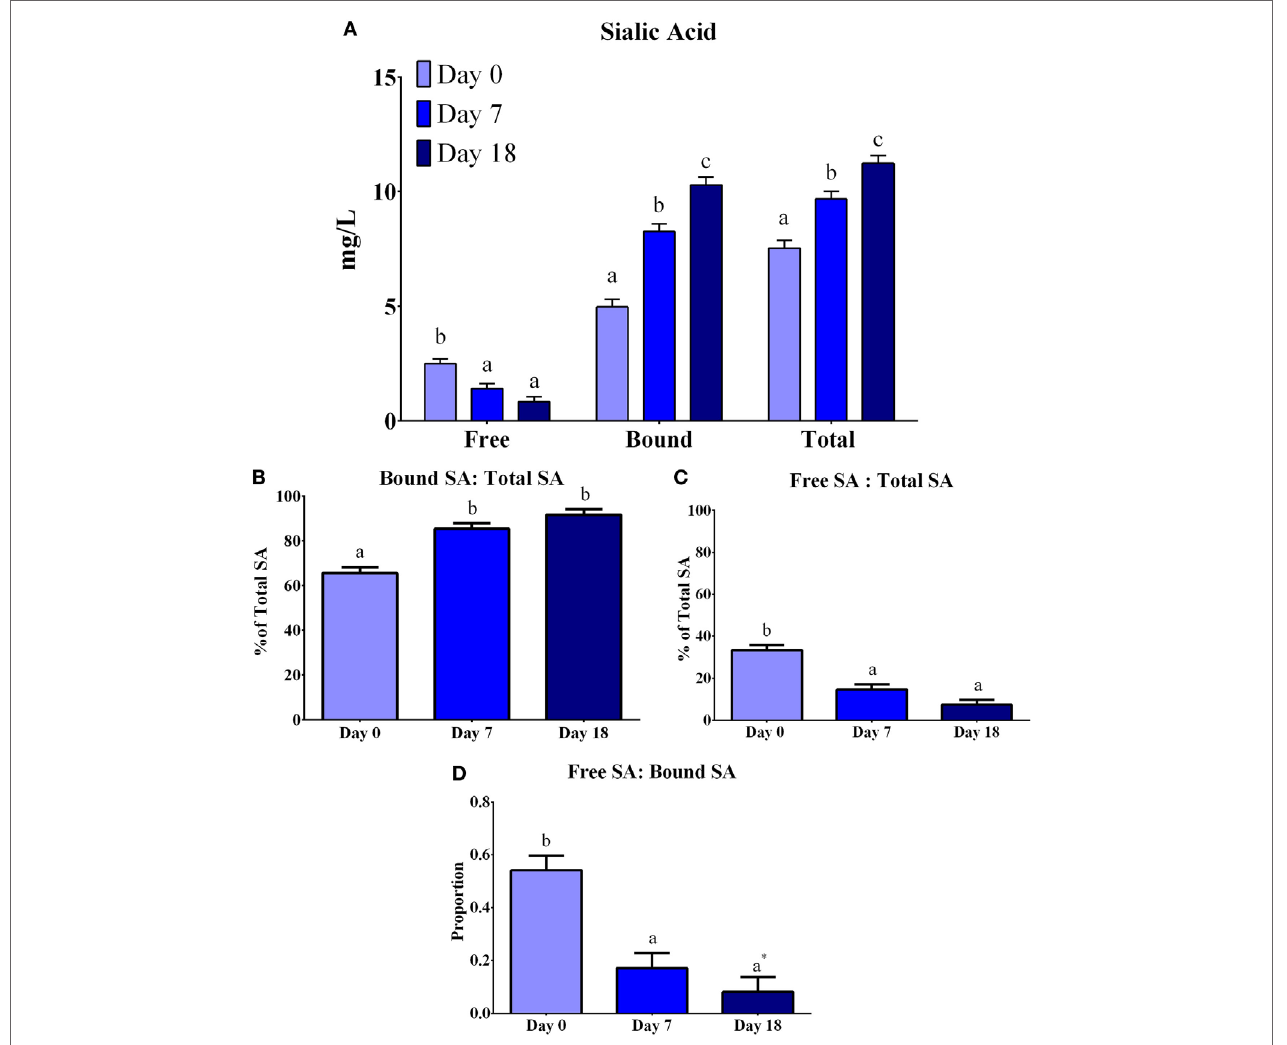
FigUre 3 | Total, free, and bound sialic acid (sa) concentration (expressed as mg neuac/l) in porcine milk . Bound SA was determined from the difference between total and free SA. (a) Concentrations of free SA decreased ( P < 0.0001), whereas bound and total SA increased ( P < 0.0001) across lactation. (B) An increase ( P < 0.0001) was observed for the ratio of bound-to-free SA from days 0 to 7 and remained constant after day 7. (c) The ratio of free-to-total SA decreased ( P < 0.0001) from days 0 to 7 and then remained constant from days 7 to 18. (D) The ratio of free-to-bound SA decreased ( P < 0.0001) from days 0 to 7 and remained constant from days 7 to 18. Means with an asterisk (*) are not statistically different than 0 ( P < 0.05). abc Indicate statistical differences among time of milk collection during the lactation period, where means that do not share a common superscript letter differ ( P < 0.05, HSD-Tukey